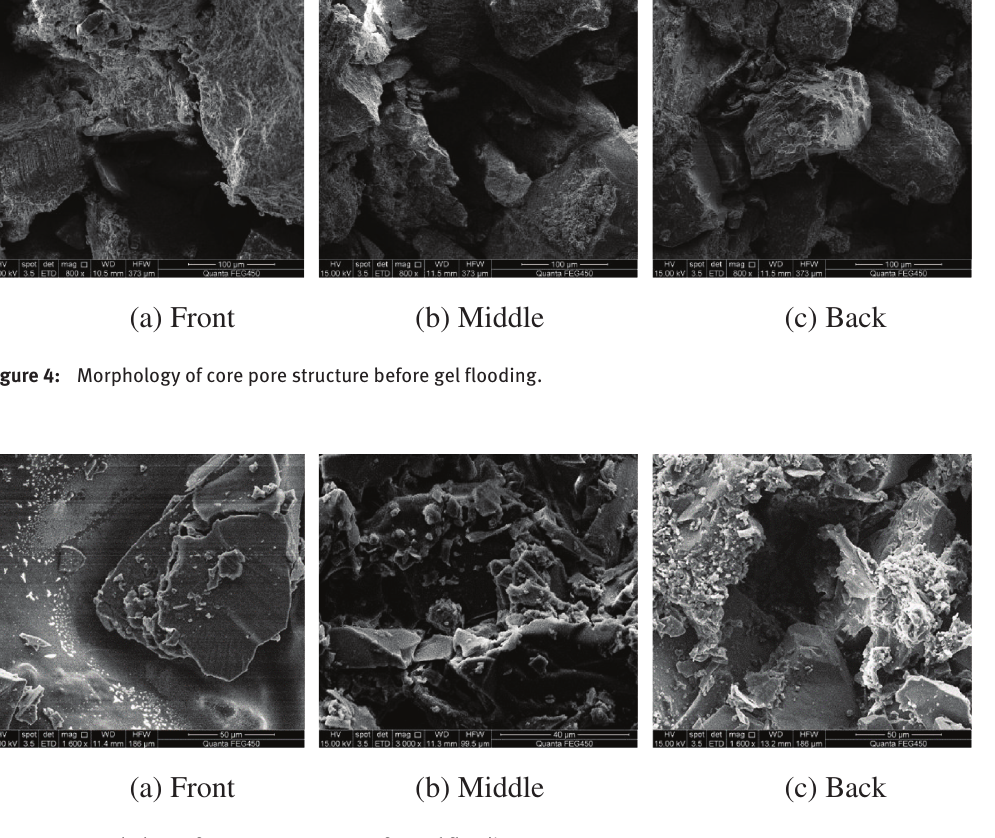
Figure 5: Morphology of core pore structure after gel